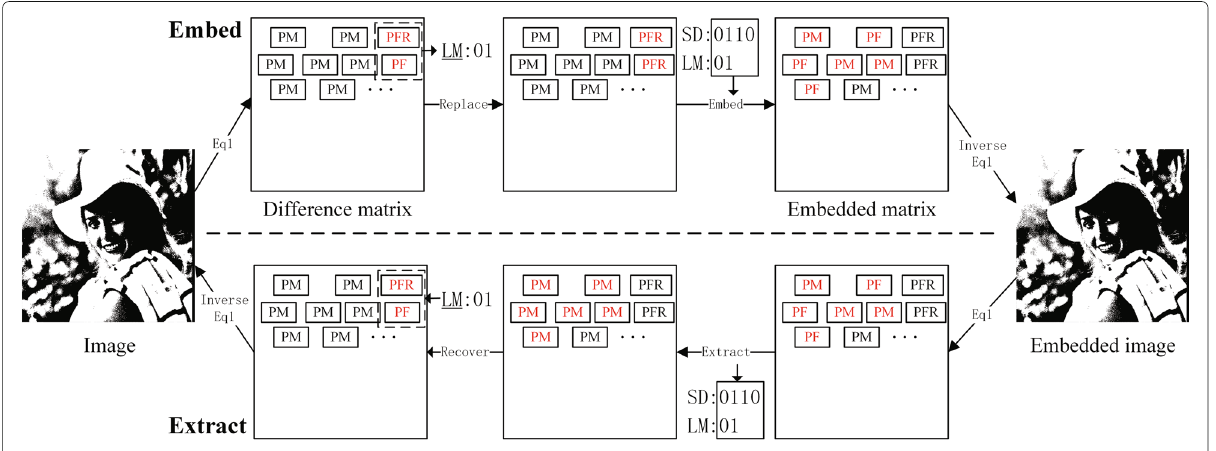
Fig. 5 An example of PFR